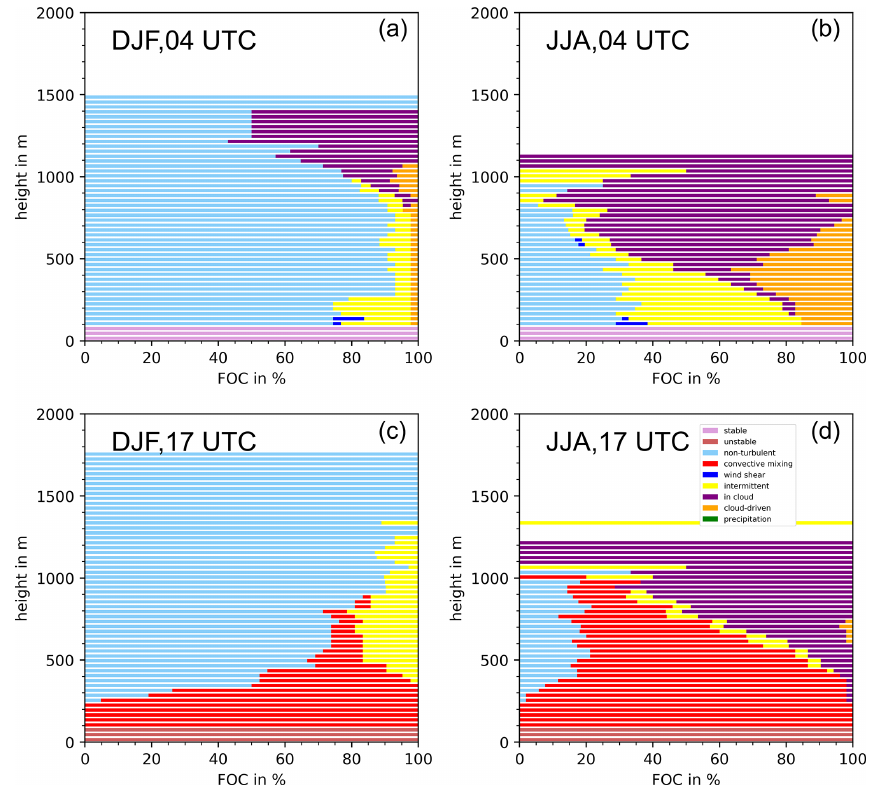
Figure 14. Frequency of occurrence of boundary-layer classes at different heights in austral summer (DJF, a , c ) and winter (JJA, b , d ) around local midnight (04:00UTC = 00:00LT, a , b ) and early afternoon (17:00UTC = 13:00LT, c , d